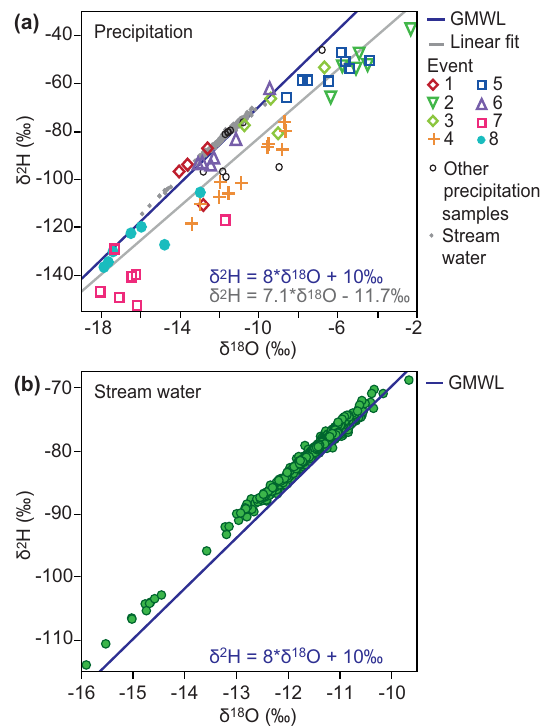
Figure 6. Dual-isotope plot of all δ 18 O and δ 2 H values measured in (a) precipitation and (b) stream water during the field experiment. The stream water samples are also plotted in grey in the upper panel for comparison (note the difference in scales). The global meteoric water line (GWML; Craig, 1961) and the linear fit to the precipita- tion data are shown in blue and in grey,